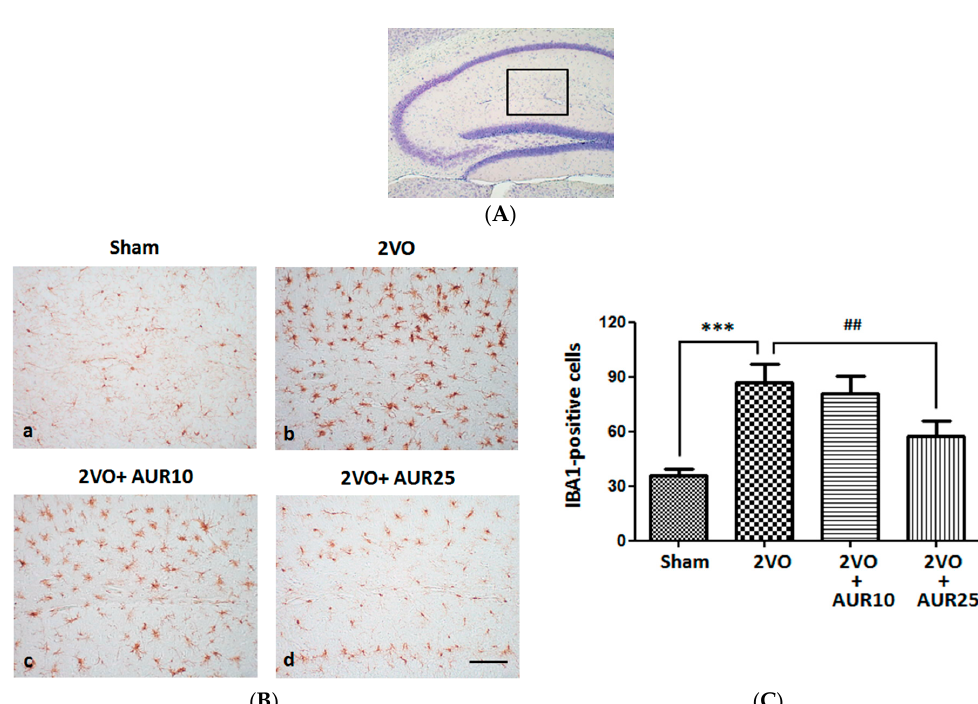
Figure 1. Effects of AUR on the activation of microglia in the hippocampus. ( A ) Region within the hippocampal region for observations of IBA-1-positive cells; ( B ) Representative photographs of IBA-1-positive cells in the indicated groups. The scale bar indicates 100 µm; ( C ) Number of IBA-1-positive cells in the four groups. Values are the means ± SEM (15~18 sections in each group). *** p < 0.001; and ## p < 0.01, as indicated by the brackets.